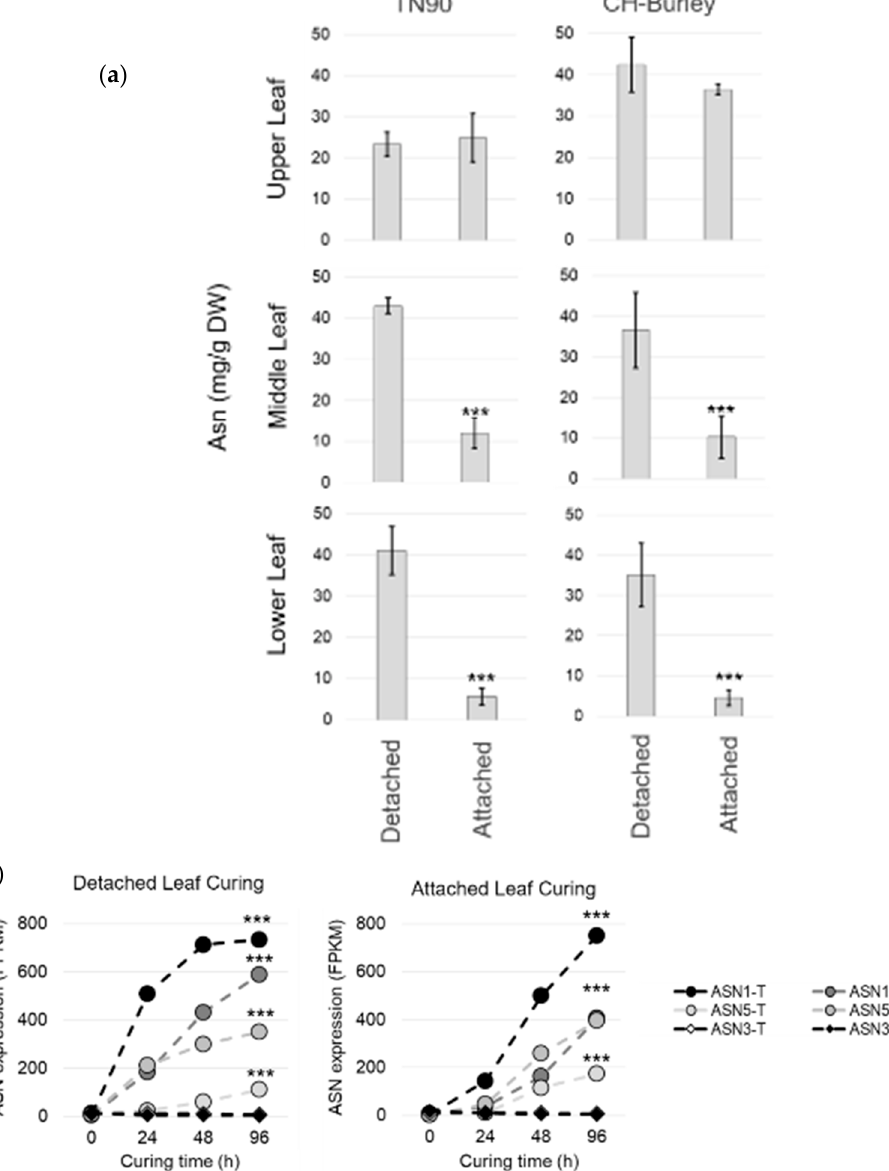
Figure 4. ( a ) Asparagine (Asn) content in air cured lower, middle, and upper leaves of two burley varieties (TN90 and CH-Burley). Leaf curing was performed either individually on string (Detached leaf) or on the stalk (Attached leaf) for 50 days. Data were collected from three biological replicates. The data are summarized in histogram bars, in which each bar represents the mean Asn content and the error bar represents the standard deviation (SD). Asterisks indicate statistical significance when comparing detached and attached leaf-curing conditions (n = 3; *** p value < 0.001; t-test). ( b ) ASN gene expression in the middle leaf position during the first 96 h of air curing either on string (Detached leaf curing; upper panel) or on stalk (Attached leaf curing; lower panel). Leaf samples from burley TN90 plants were collected during curing and used for RNA-seq analysis. Each data point is calculated from the averaged FPKM (Fragments Per Kilobase of exon per Million Fragments Mapped) values and represents the relative expression level of the gene. Data were collected from three biological replicates. Vertical bars are SD. Asterisks indicate statistical significance when comparing the expression levels at the start and after 4 days of curing (n = 3; ***p < 0.001; t-test). Finally, we compared the accumulation of Glu, Gln, Asp, and Asn between detached and attached leaves during the curing time course (Figure 5). The metabolomic data show 70% less Asn